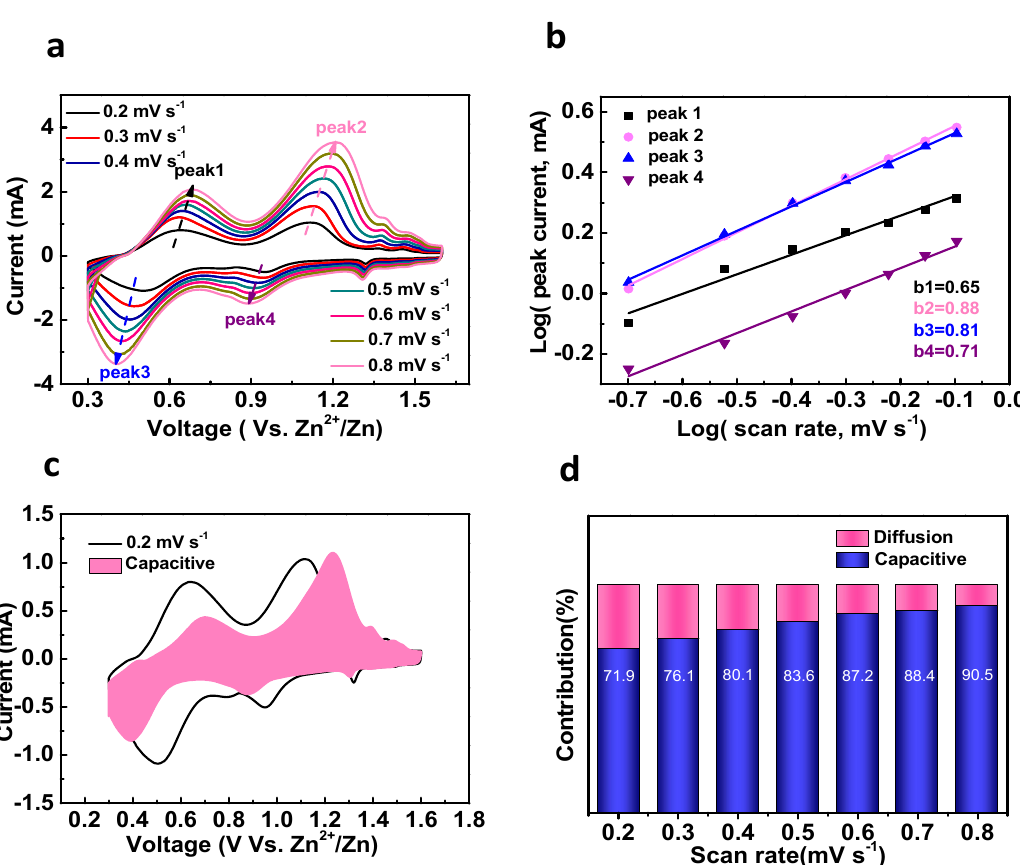
Figure 3. ( a ) CV profiles of KNVO at different scan rates from 0.2 to 0.8 mV s − 1 . ( b ) log( i ) versus log( ν ) curves of cathodic and anodic peaks. ( c ) Capacitive (pink line) contribution to charge storage at 0.2 mV s − 1 . ( d ) Contribution to charge storage at different scans.